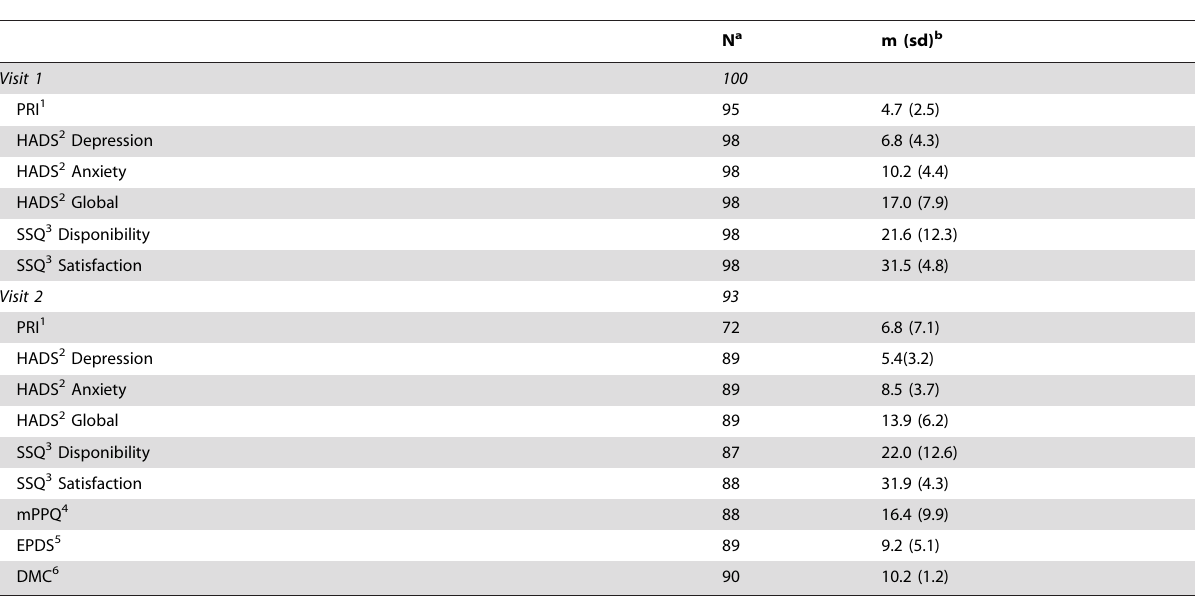
Table 2. Mean scores of evaluation scales at visit 1 and visit 2.